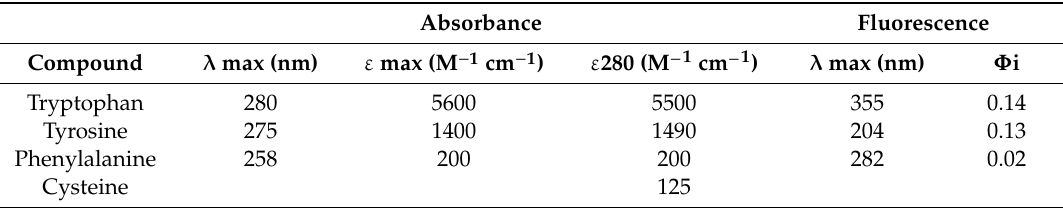
Table 1. Absorbance and fluorescence of aromatic amino acids and cysteine in water. In the lower part, it is presented how to calculate the extinction coe ffi cient of a protein, Φ is the quantum yield.